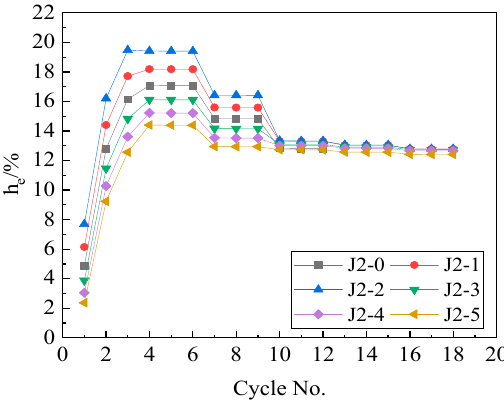
Figure 24. Equivalent viscous damping ratio–cycle no. curves.